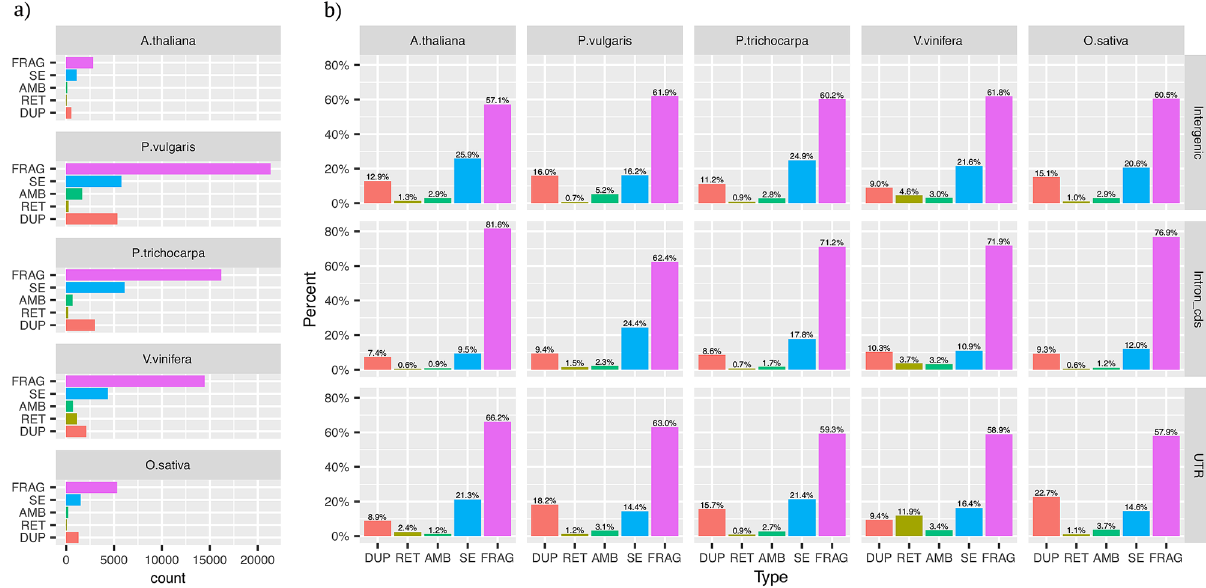
Figure 3. Distributions of pseudogenes according to presence/absence of introns ( a ) Total number of peudogenes types for the five investigated species. ( b ) Distribution of pseudogenes (as relative frequencies) among the different genomic regions. FRAG fragmented, SE single-exon pseudogenes, AMB ambiguous pseudogenes, RET processed